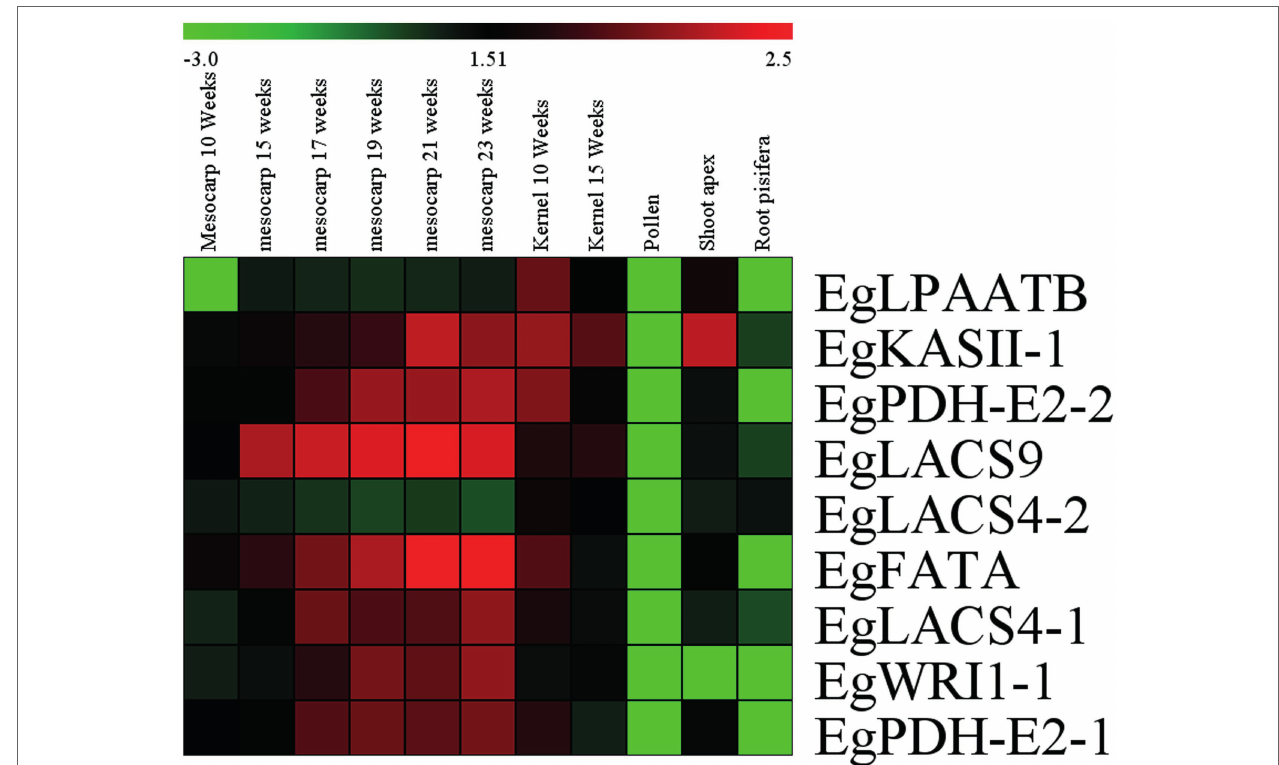
FIGURE 6 | Heat map of candidate genes expression in different tissues of Elaeis guineensis . Log 10RPKM value were sued to construct the heat map with